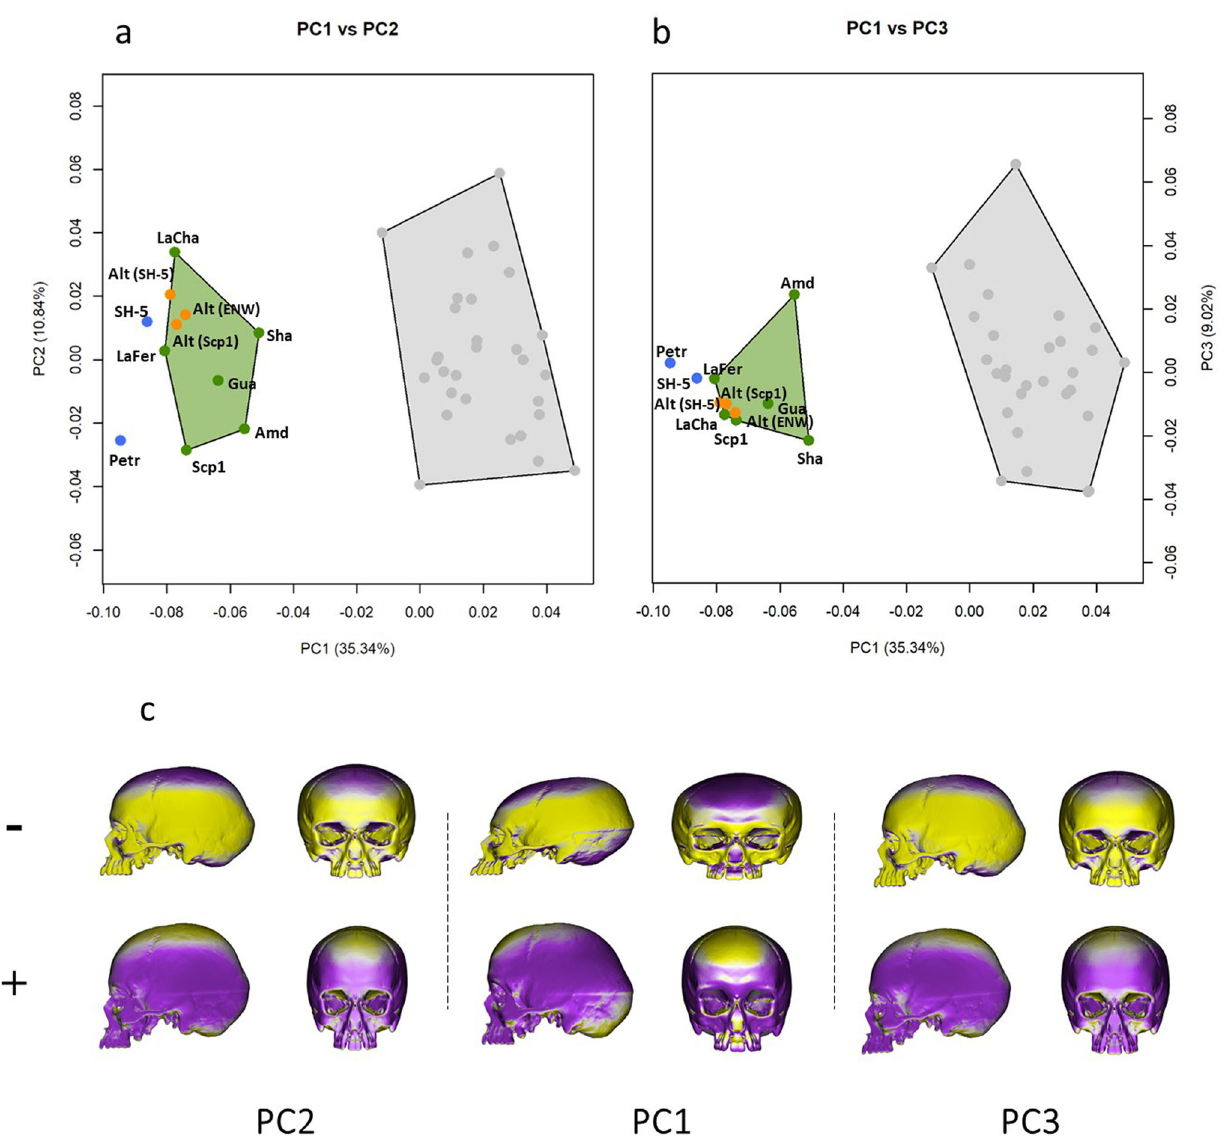
Fig. 3 Principal Component Analysis comparing Altamura with crania of Neanderthal lineage and of modern humans. a PC1 vs PC2. b PC1 vs. PC3. Full circles represent fossil specimens; orange: virtual reconstructions of Altamura based on SH-5 (Alt-SH-5), on the mean shape of the EWN sample (Alt-ENW) and on Saccopastore 1 (Alt-Scp1); blue: Mid-Pleistocene specimens (SH-5: Sima de los Huesos 5; Petr: Petralona); green: Homo neanderthalensis (Amd: Amud; Gua: Guattari 1; LaFer: La Ferrassie; LaCha: La Chapelle; Scp1: Saccopastore 1; Sha: Shanidar); grey: Homo sapiens . c Cranial morphology associated at extreme negative ( − ) and positive ( + ) values of the fi rst three principal components; yellow and violet respectively indicate local expansion and contraction from the mean